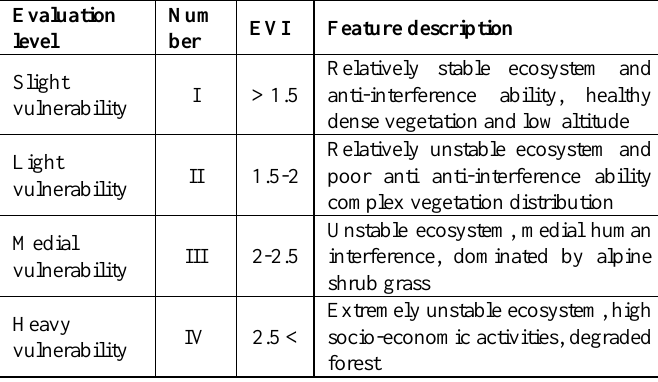
Table 3 . The result of environmental vulnerability classification in the Olomouc